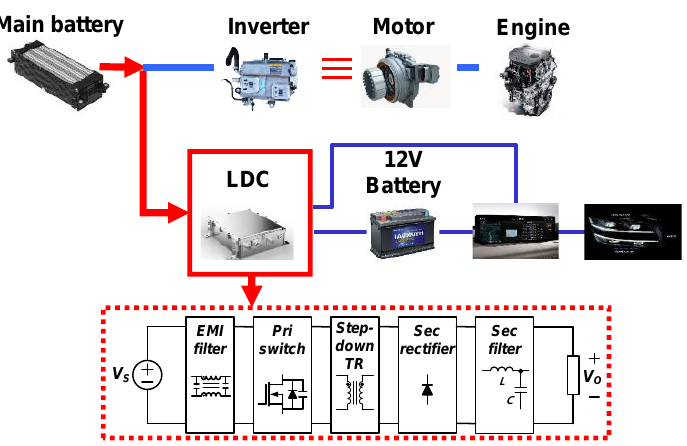
Figure 1. Low-voltage system of xEVs.